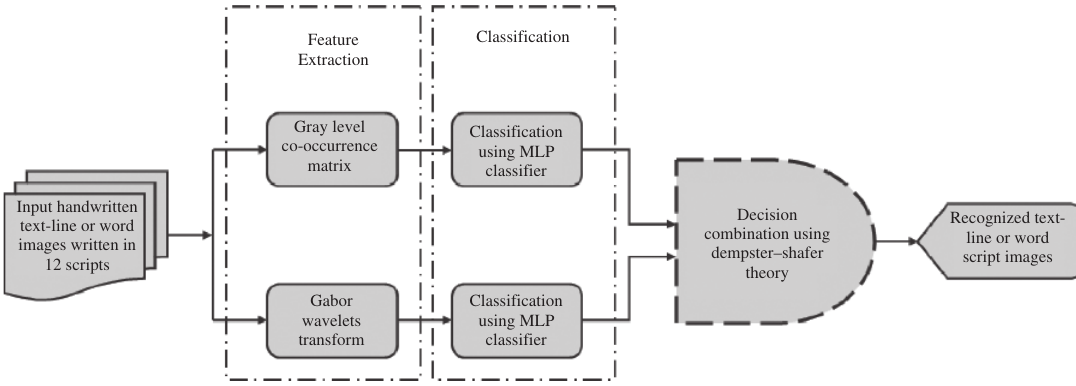
Figure 1: Schematic Diagram of the Present